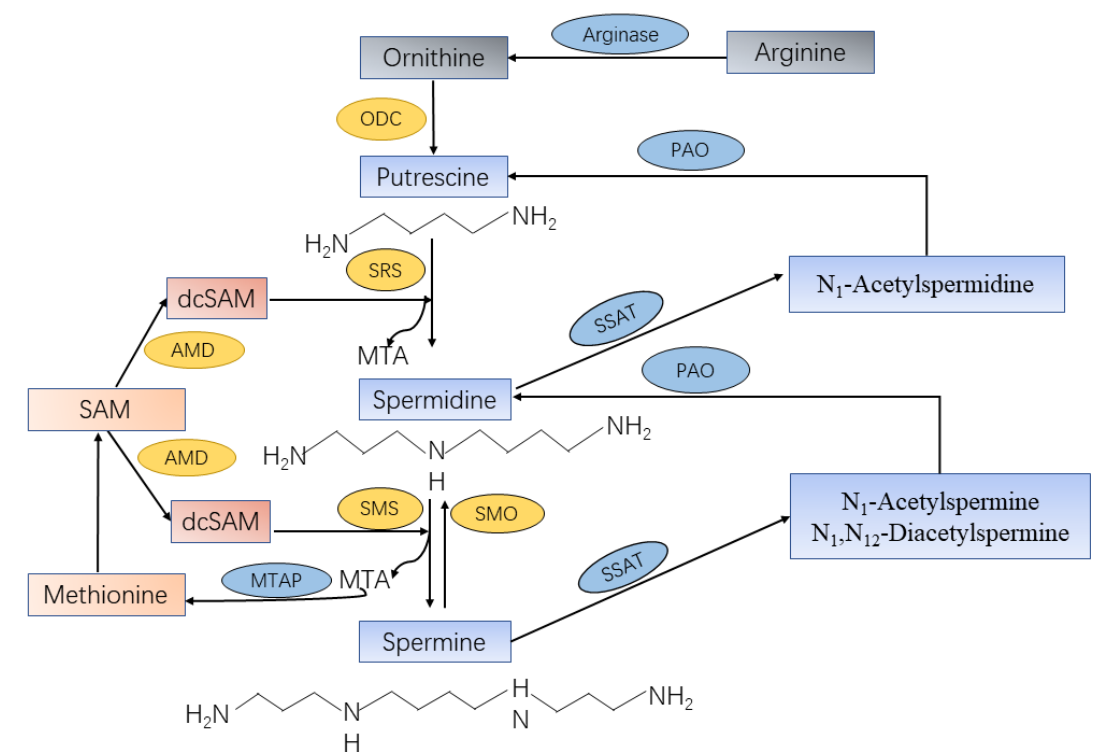
Figure 1. Spermine synthesis and catabolism in mammalian cells. Arginine produces ornithine through the action of arginase. Ornithine decarboxylase (ODC) is the first rate-limiting enzyme in spermine synthesis, in which ornithine is decarboxylated to produce putrescine. Spermidine synthase (SRS) and spermine synthase (SMS) are constitutively expressed aminopropyltransferases that catalyze the transfer of the aminopropyl group from decarboxylated S-adenosylmethionine (dcSAM) to putrescine and spermidine to form spermidine and spermine, respectively, as well as methylthioadenosine (MTA). The dcSAM is converted from S-adenosylmethionine (SAM) by enzymatic role of adenosylmethionine decarboxylase (AMD) as a second rate-limiting enzyme in polyamine synthesis. The central enzyme in the polyamine catabolic pathway is spermidine-spermine-N1-acetyltransferase (SSAT), which monoacetylates spermidine and mono-/diacetylates spermine. These acetylated polyamines are the substrates of N1-acetylpolyamine oxidase (PAO), which are catalyzed to form putrescine or spermidine, respectively. Spermine can be oxidized directly and specifically to produce spermidine by spermine oxidase (SMO).